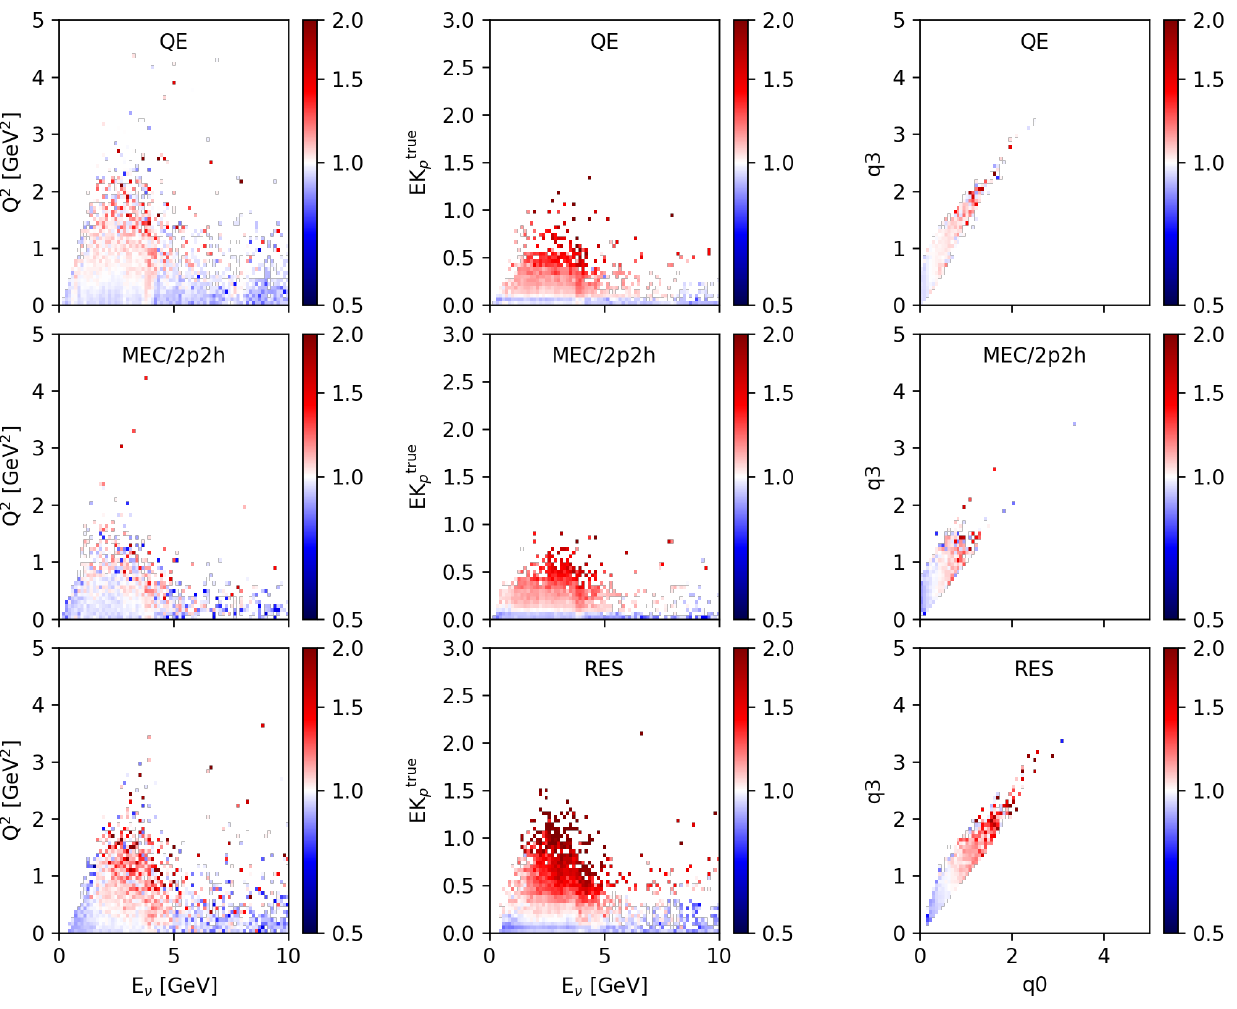
Figure 97. RHC event weights binned in interaction mode and three pairs of true kinematic variables: true neutrino energy vs. Q 2 ( left ); true neutrino energy vs true proton kinetic energy ( middle ); and q 0 vs. q 3 ( right